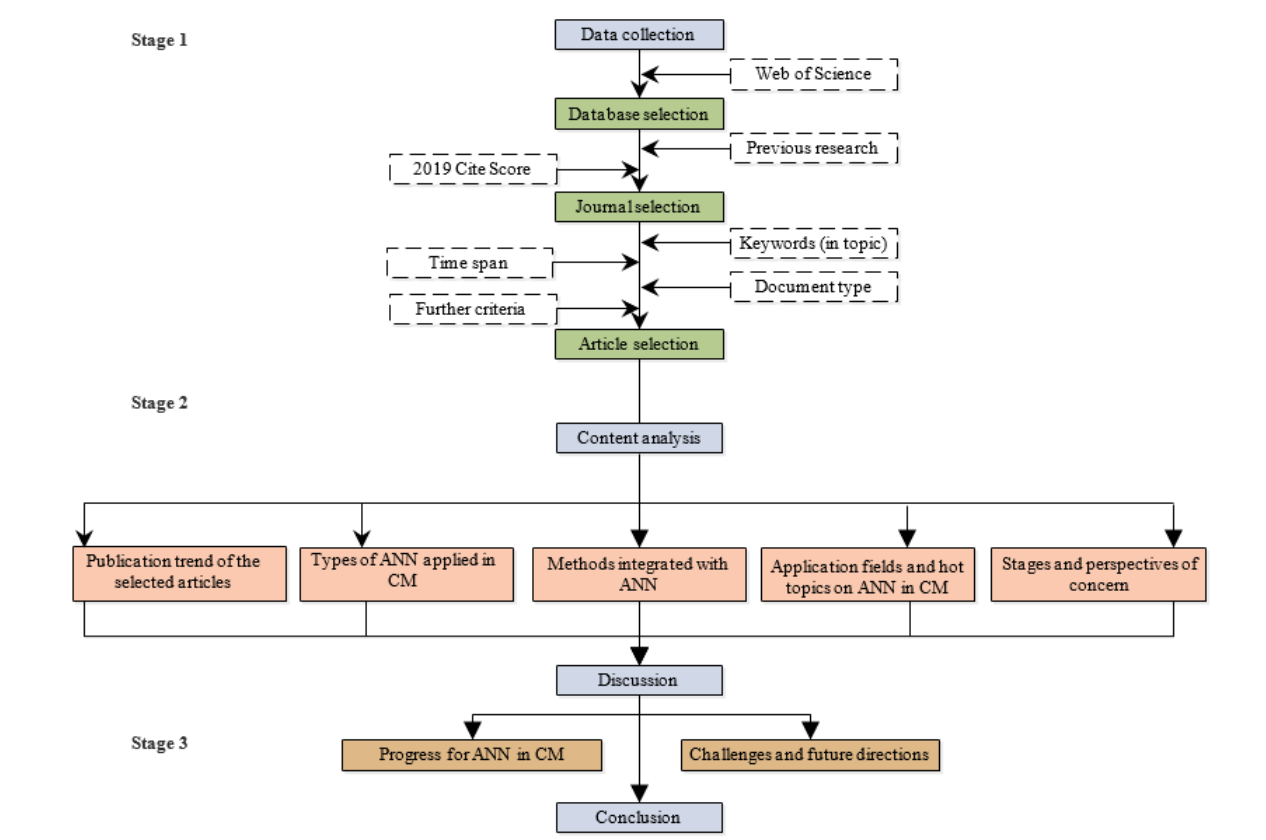
Figure 2. Outline of the three-stage process of research methodology. Table 2. Distribution of the selected papers among different